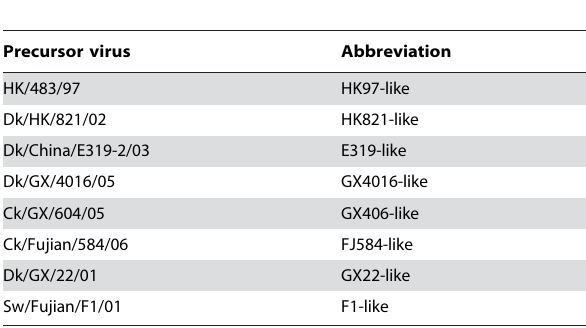
Table 2. Putative precursor viruses of HPAI H5N1 from Vietnam.